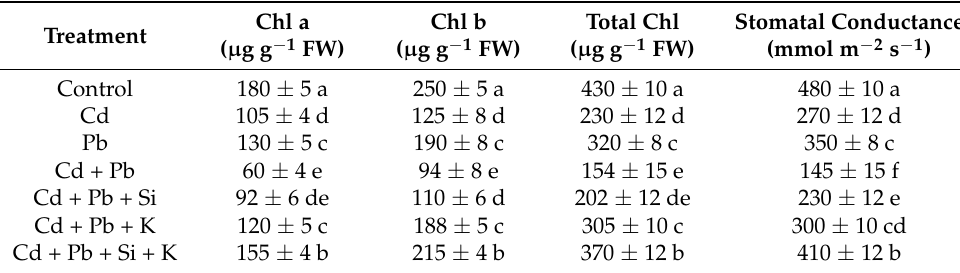
Table 2. Pigment contents and stomatal conductance of quinoa plants under Cd and Pb treatments with and without supplementation of Si and